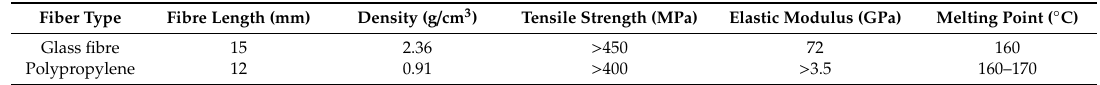
Table 1. Physical properties of fibres.